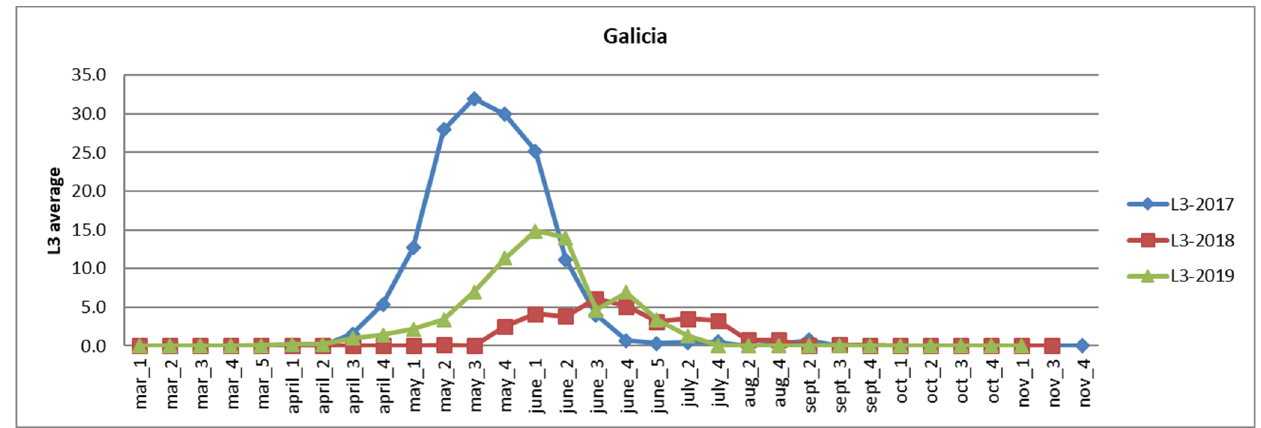
Figure 10. Evolution of the average number of larvae in stage L3, according to the week of the survey month.